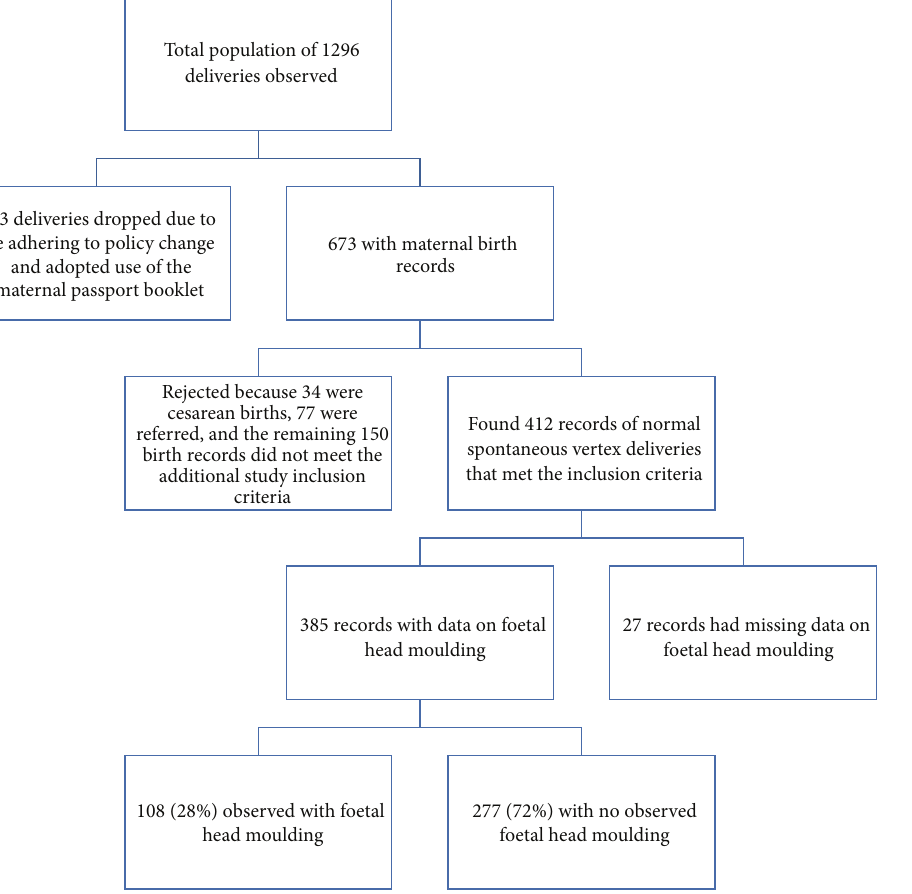
Figure 2: Flow diagram showing participant record selection.